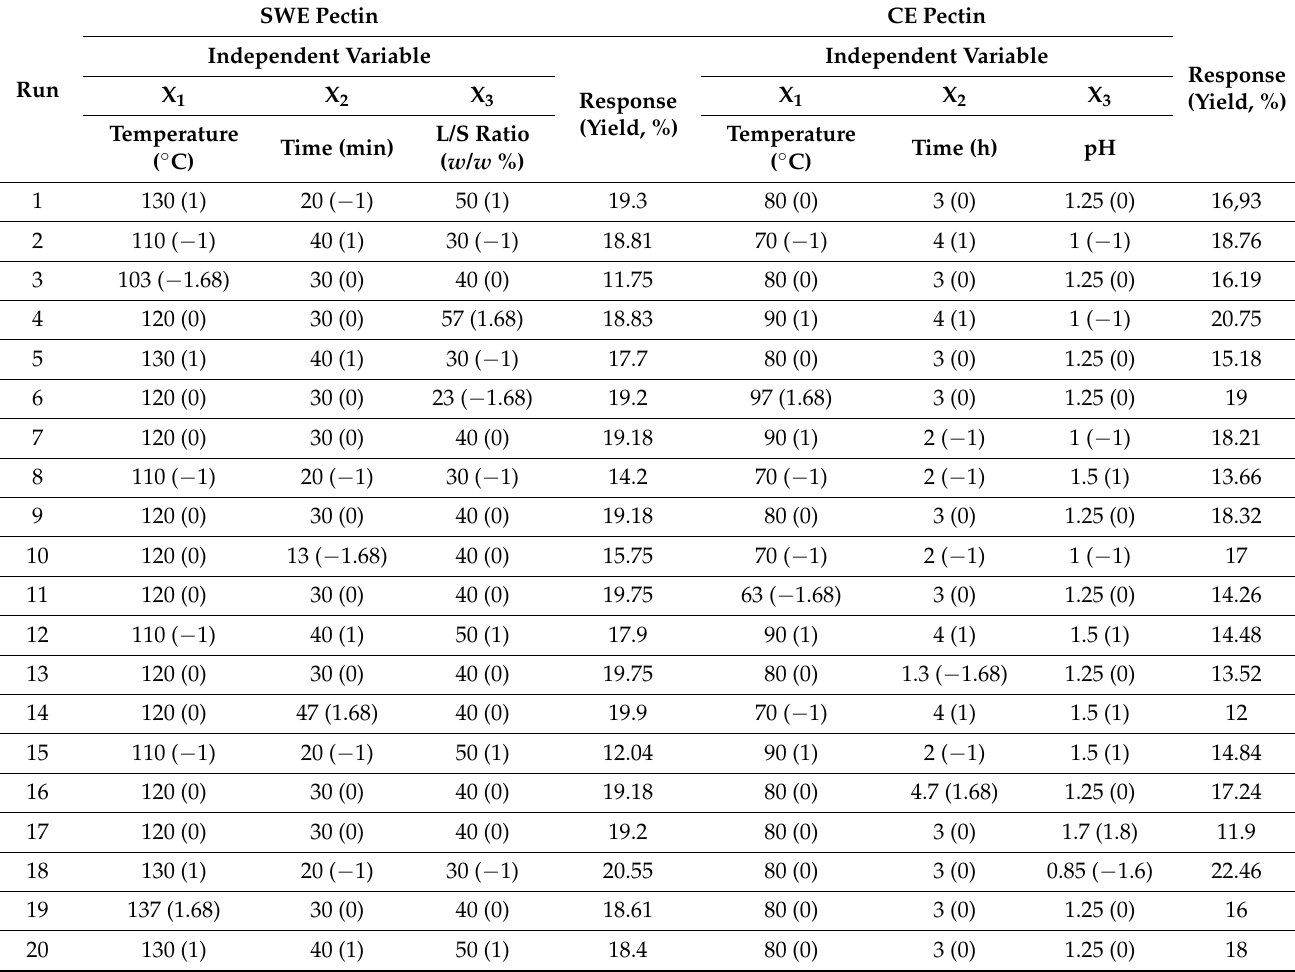
Table 4. Experimental design of the levels, variables of central composite, and pectin yield by SWE and CE. SWE Pectin CE Run